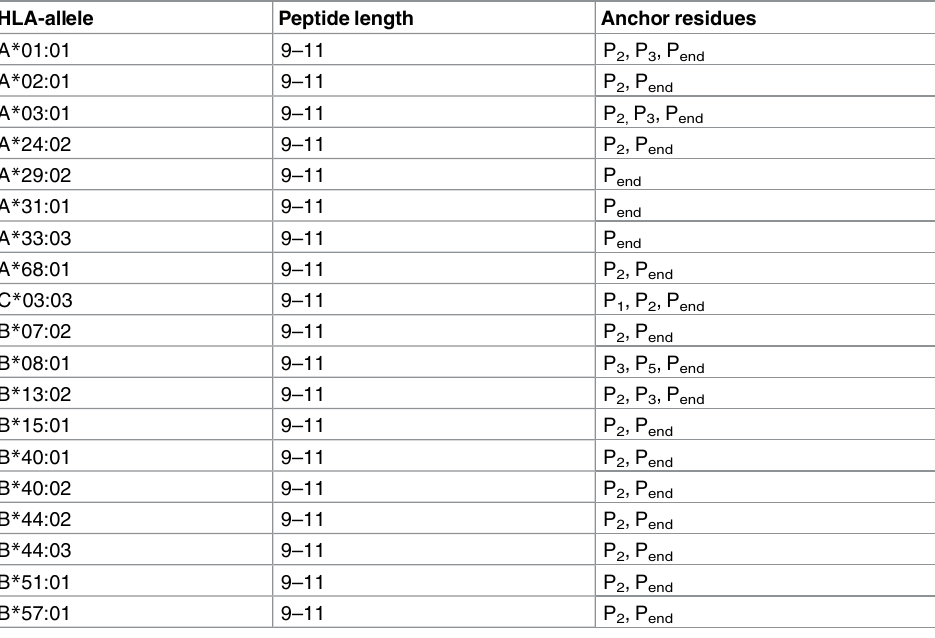
Table 3. Bindingmotifsfor HLA class I